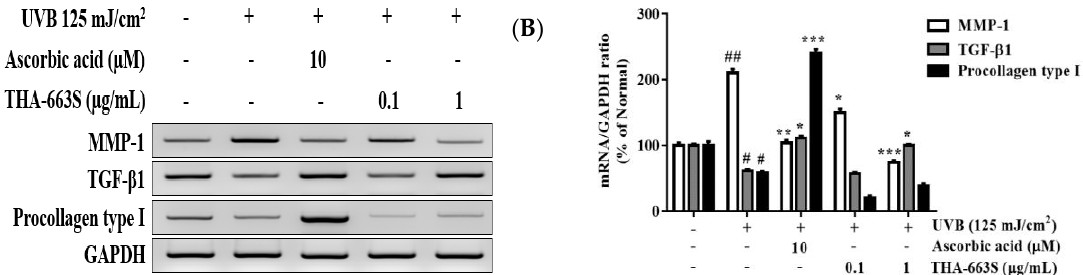
Figure 5. MMP-1, TGF- β1, and procollagen type I mRNA expression on HaCaT cells of THA -663S. Following UVB irradiation (125 mJ/cm 2 ), HaCaT cells were treated with or without the shown concentrations of THA-663S (0.1 and 1 µg/mL) for 24 h. The MMP-1, TGF- β1, and procollagen type I mRNA levels were measured using RT-PCR analysis ( A ). The band intensities were quantified by densitometry, normalized to the level of GAPDH, and calculated as the percentage of the non-irradiated group ( B ). The results are shown as the mean ± SD of three independent experiments. # p < 0.05, ## p < 0.01 compared with non-irradiated group, * p < 0.05, ** p < 0.01, *** p < 0.001 compared with only UVB-irradiated group.